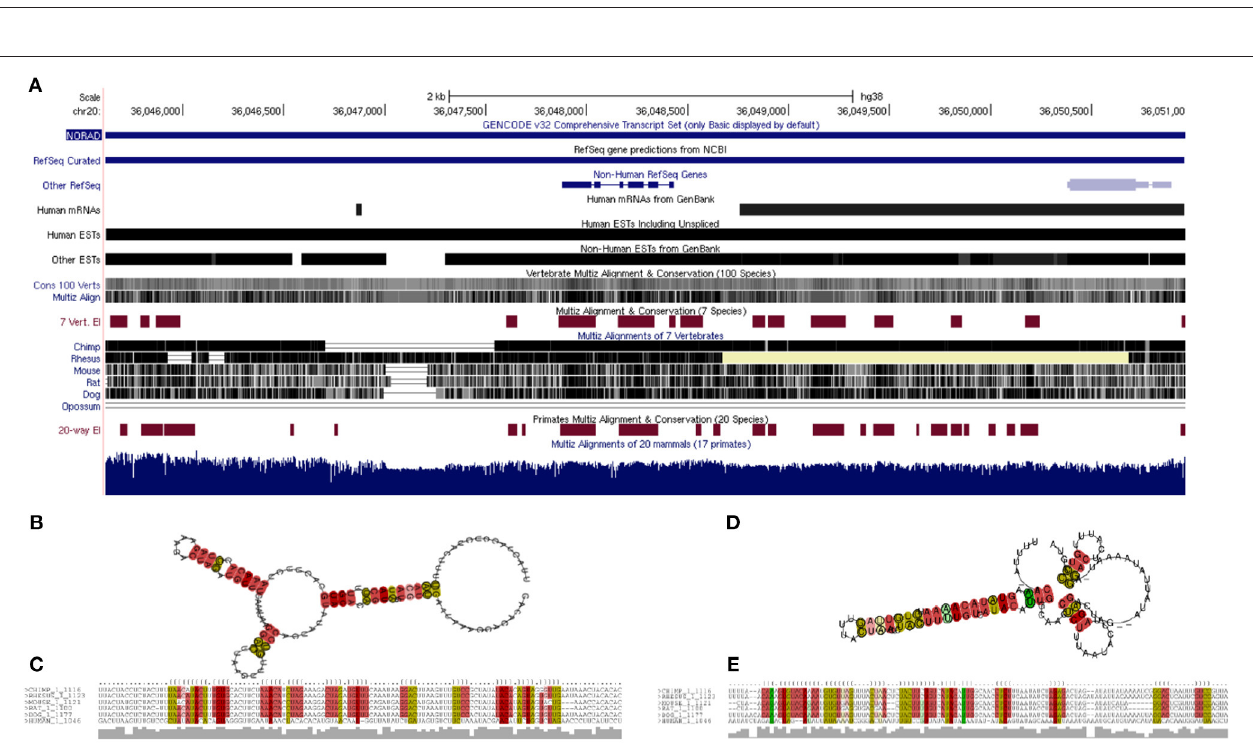
Frontiers in Bioengineering and Biotechnology |